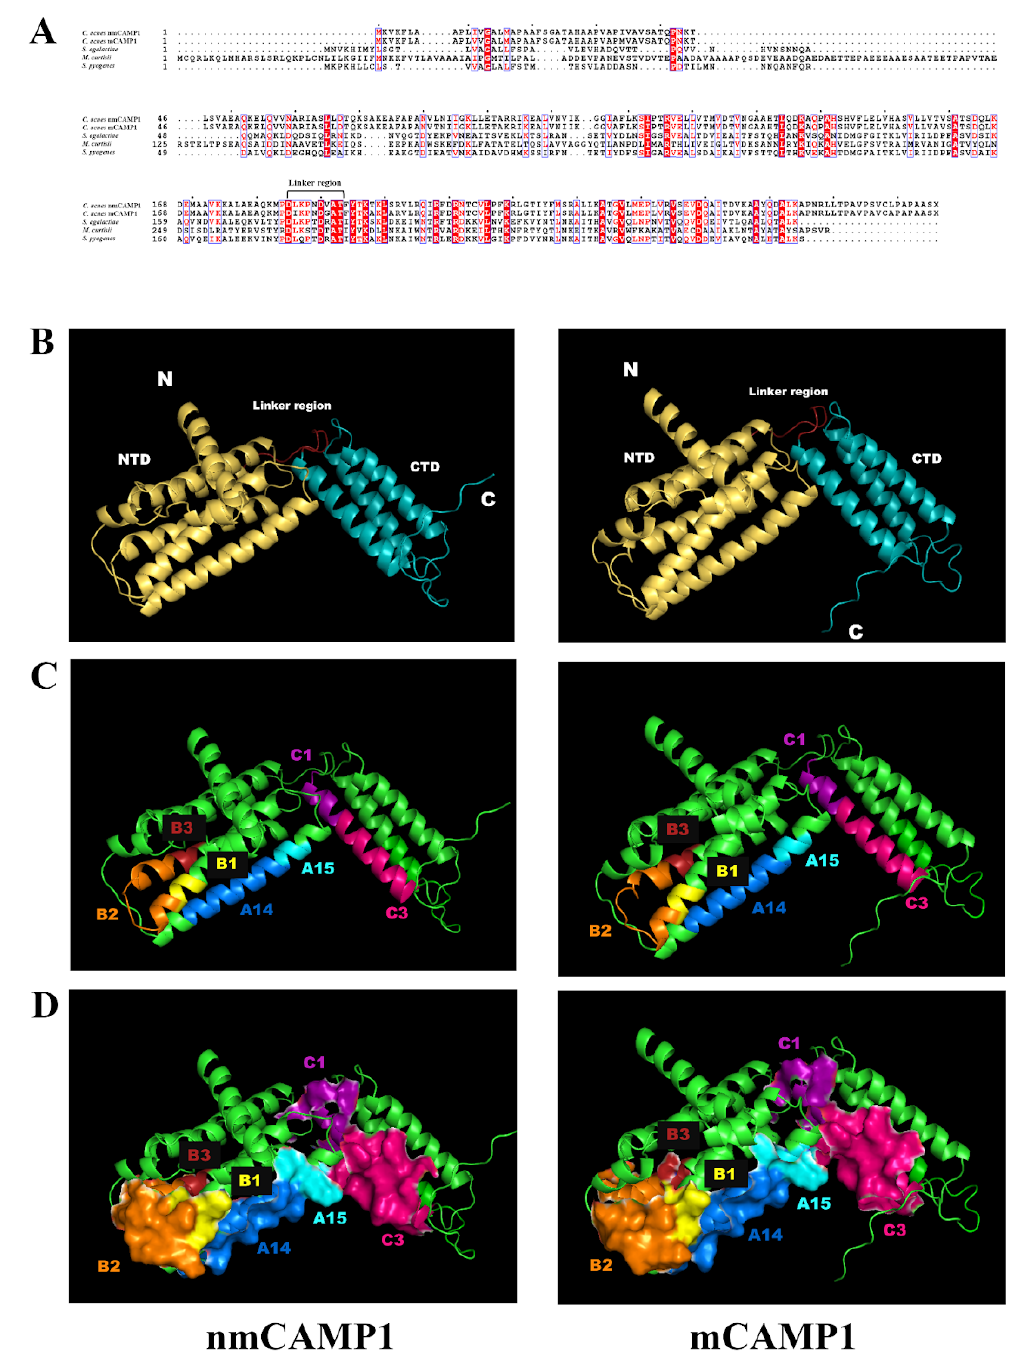
Figure 5. In silico 3D analysis of C. acnes factor CAMP1. ( A ) Sequence alignment of CAMP factors from different species. Conservatively substituted residues are boxed and strictly conserved residues are highlighted with a red background. The figure was constructed with ESPript 3.0. Reference sequences: Cutibacterium acnes nmCAMP1: AAS92206.1; Cutibacterium acnes mCAMP1: KX581410; Streptococcus agalactiae : ZP_08649639.1; Mobiluncus curtisii : YP_003718285.1; Streptococcus pyogenes : WP_111681137.1. ( B – D ) Predicted structures of the nmCAMP1 and mCAMP1 proteins obtained by homology modeling with the trRosetta server and the images generated with PyMOL software. ( B ) Cartoon representation of CAMP1. The NTD domain is colored in yellow, the CTD domain in cyan and the linker region in red. ( C ) CAMP1 peptides involved in TLR-2 binding are highlighted: A14 in blue, A15 in cyan, B1 in yellow, B2 in orange, B3 in red, C1 in purple and C3 in pink. ( D ) Surface representation of CAMP1 peptides.